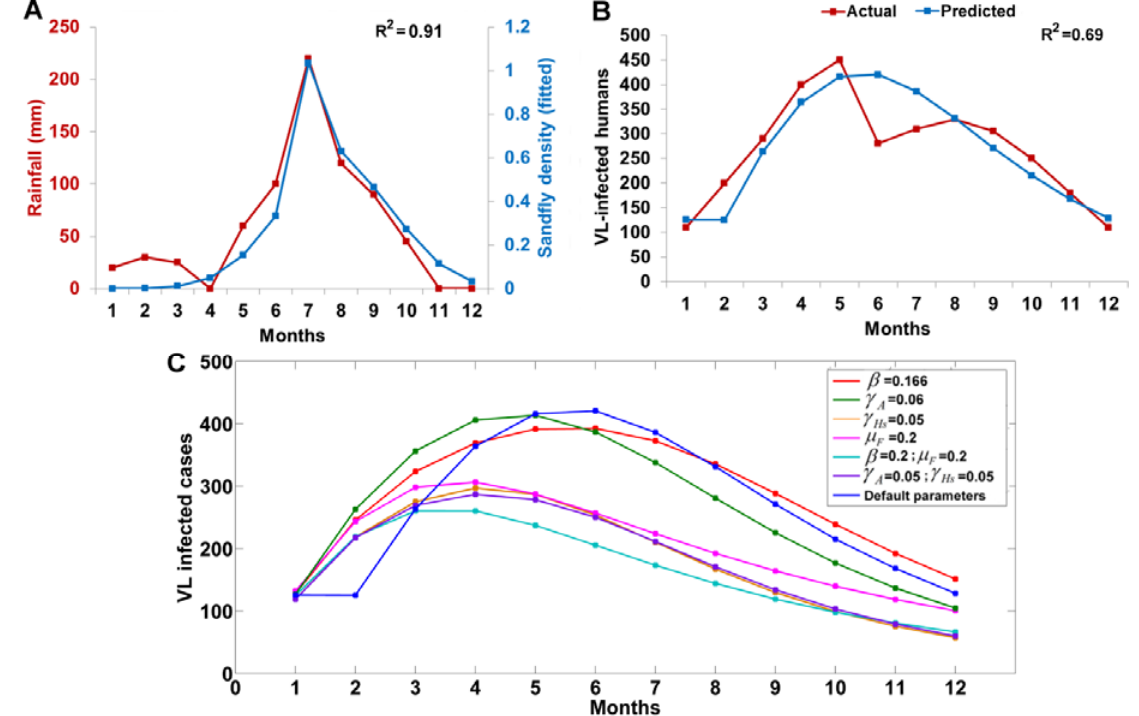
Figure 7. Testing model with real data—( A ) Monthly average sandfly density versus monthly average rainfall in 2005; ( B ) Observed (actual) VL-infected cases in the Muzzafarpur district, Bihar, India (2005) vs. predicted VL infected cases from the model. R 2 indicates